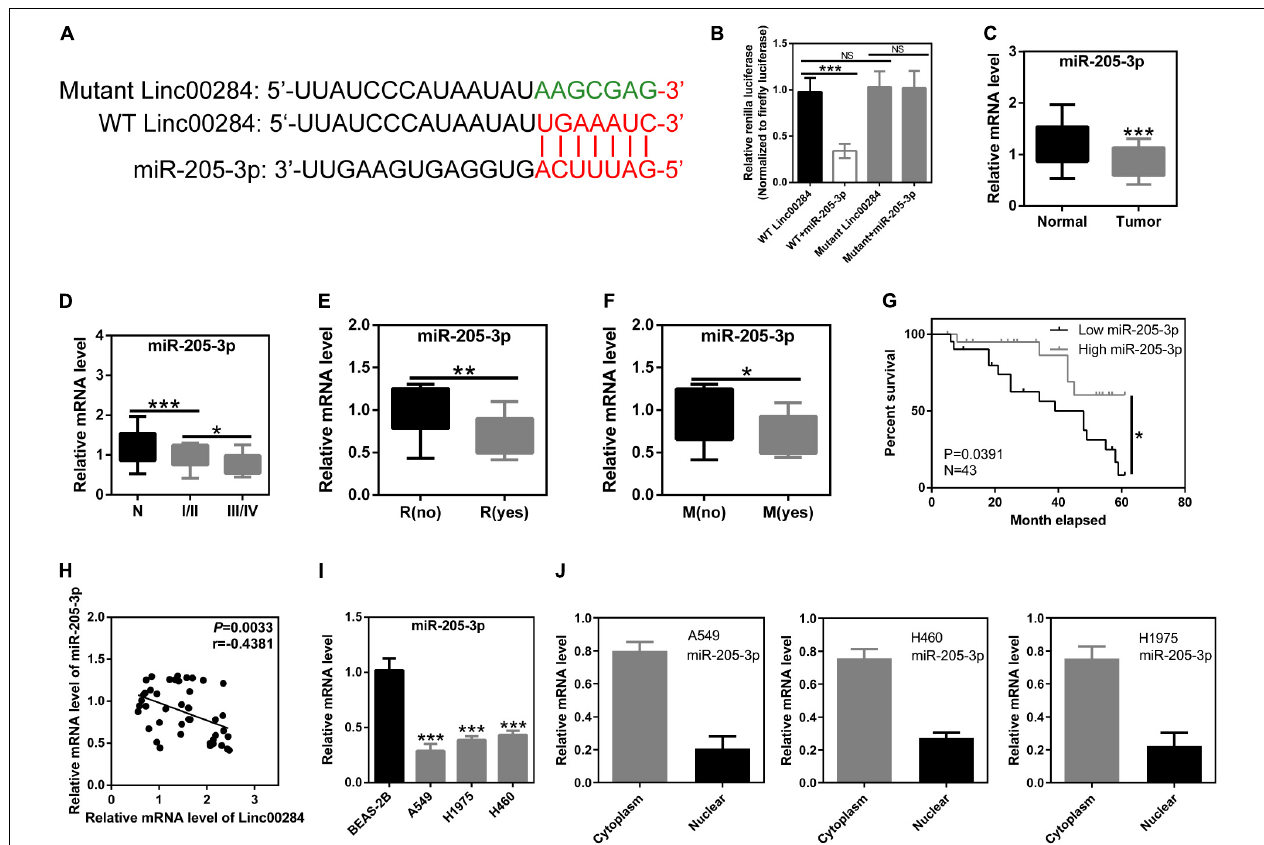
FIGURE 4 | Linc00284 directly targets miR-205-3p. (A) Schematic representation of direct binding sites between Linc00284 and miR-205-3p. Red indicates the predicted binding sites between Linc00284 and miR-205-3p. Green indicates the mutant sequence of Linc00284. (B) Dual-luciferase reporter assay confirmed direct interaction between miR-205-3p and Linc00284. (C) RT-qPCR revealed the significant downregulation of miR-205-3p in lung cancer tissues. (D–G) miR-205-3p expression was associated with (D) TNM stage, (E) recurrence, (F) metastasis, and (G) overall survival of patients with lung cancer. (H) Pearson’s correlation analysis indicated that miR-205-3p expression was negatively correlated with the Linc00284 level in tumor tissues. (I) miR-205-3p expression was significantly upregulated in A549, H1975, and H460 lung cancer cell lines. (J) miR-205-3p was mainly located in the cytoplasm of lung cancer cells. Data are expressed as the means ± SD for triplicate independent experiments. The expression of miR-205-3p in 43 lung cancer tissues and paired adjacent non-cancerous tissues was analyzed using paired t -test. Multiple comparisons were analyzed using one-way ANOVA followed by Tukey’s test. Kaplan–Meier analysis was used for survival analysis. Correlation analysis was assessed using Pearson’s correlation analysis. Descriptive statistics were used to analyze the expression of miR-205-3p in the cytoplasm and in the nucleus of LC cells. * P < 0.05, ** P < 0.01, and *** P < 0.001, compared with the matched control group. NS, not significant. N, adjacent normal tissues; T, tumor tissues; R, recurrence; M,